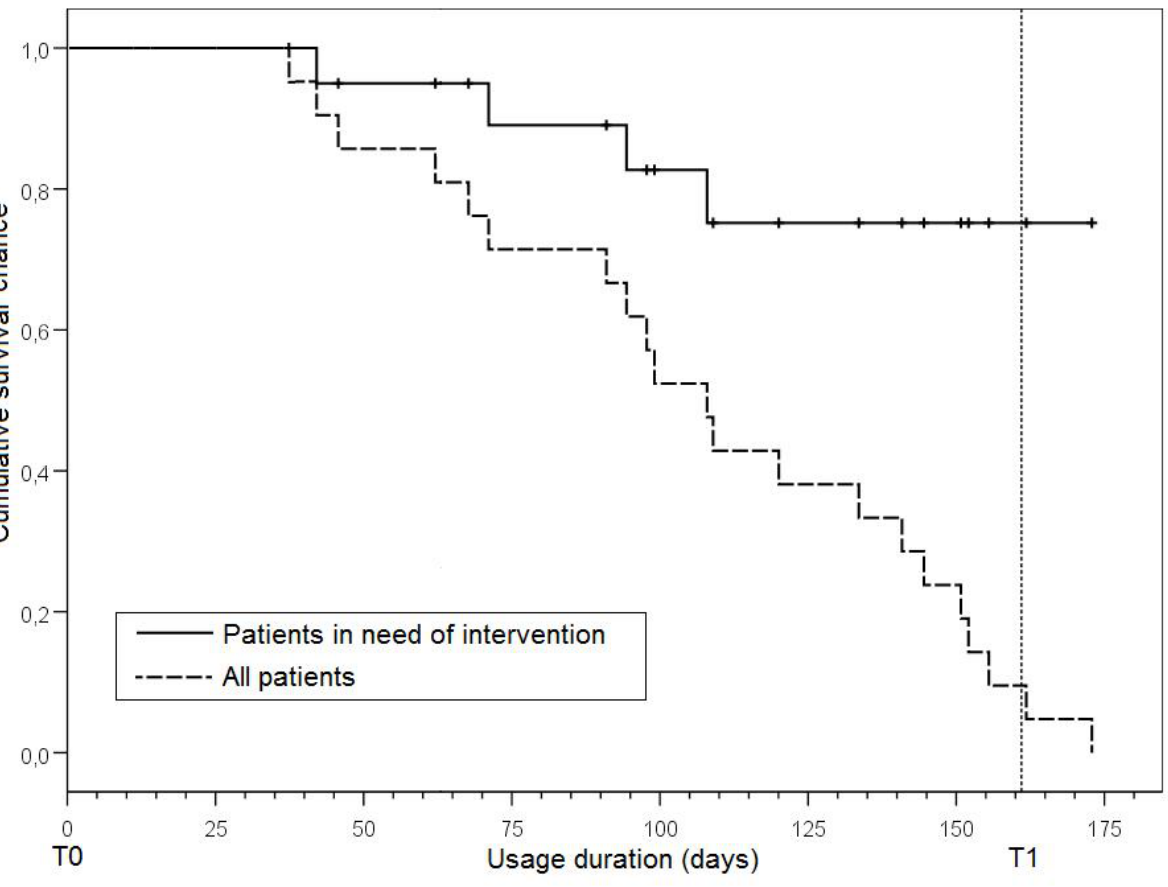
Figure 3. Kaplan-Meier survival analysis for use of intervention (dotted vertical line denotes Time 1 at beginning of the 24th week)